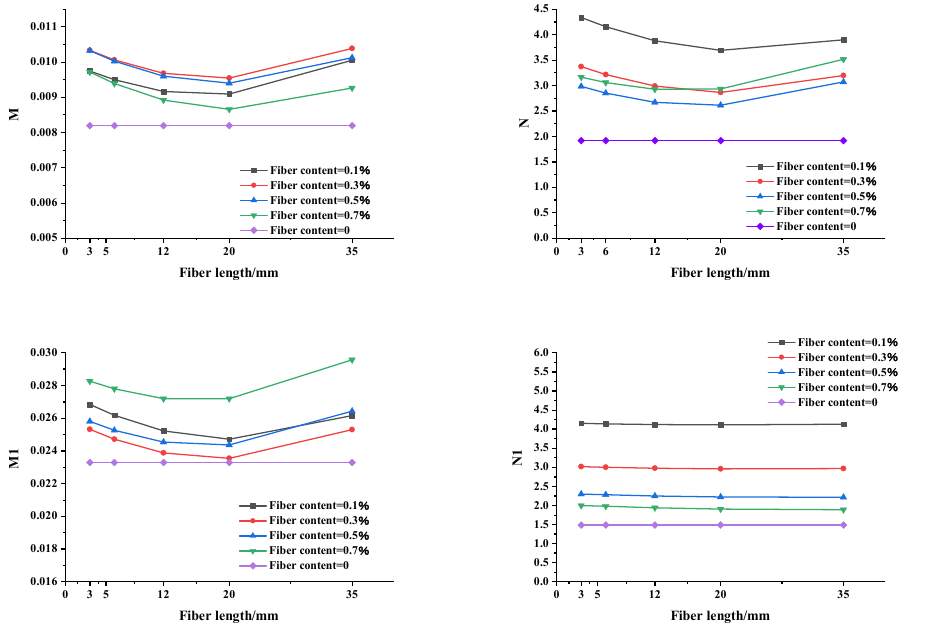
Figure 12. Varying trends in the parameters m, n, m 1 , and n 1.